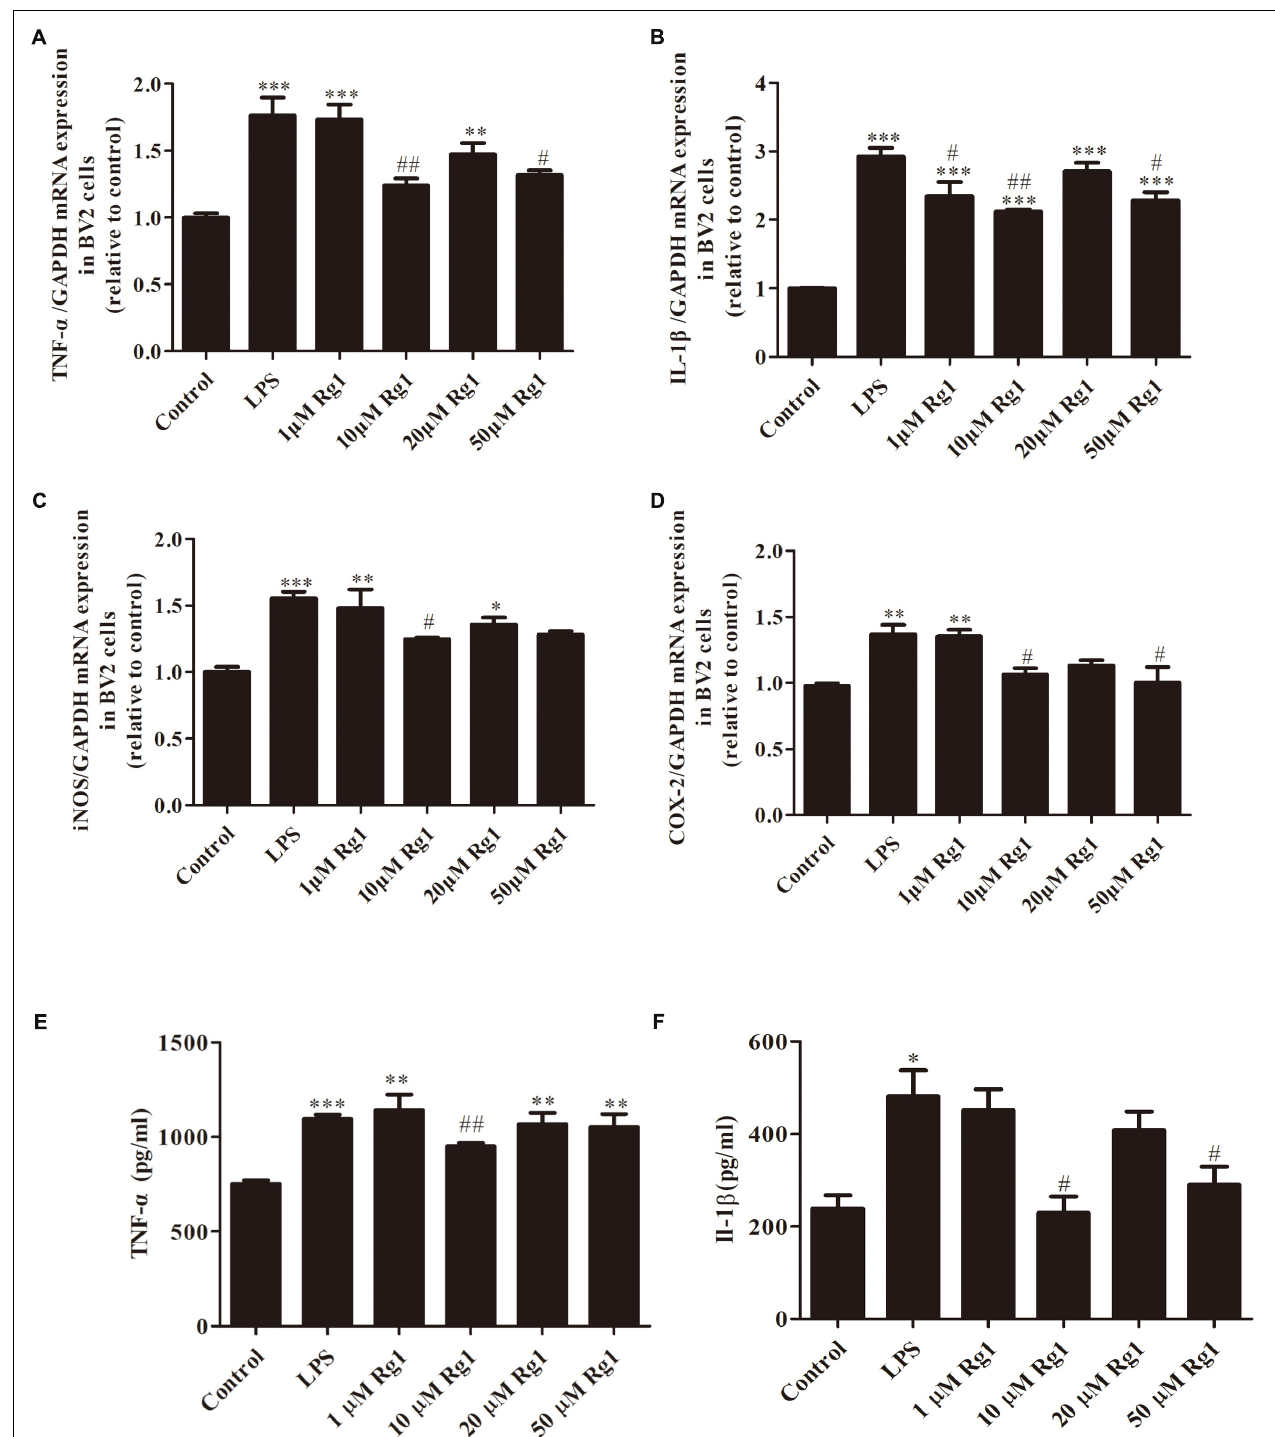
FIGURE 2 | The inhibitory effects of different dosages of Rg1 on LPS-induced production of TNF- α , interleukin-1 β (IL-1 β ), iNOS, and COX-2 in BV2 cells. BV2 cells were treated with the indicated concentration of Rg1 (1, 10, 20, and 50 µ M) 1 h before LPS (1 µ g ml − 1 ) treatment for 6 h. TNF- α (A) , IL-1 β (B) , iNOS (C) , and COX-2 (D) mRNA levels were measured by real-time PCR; GAPDH was used as an internal control ( n = 4). TNF- α (E) and IL-1 β (F) protein levels were detected by ELISA ( n = 3). Results are expressed as the mean ± SEM. ∗ P < 0.05, ∗∗ P < 0.001, and ∗∗∗ P < 0.001 versus the control; # P < 0.05 and ## P < 0.01 versus the LPS group.